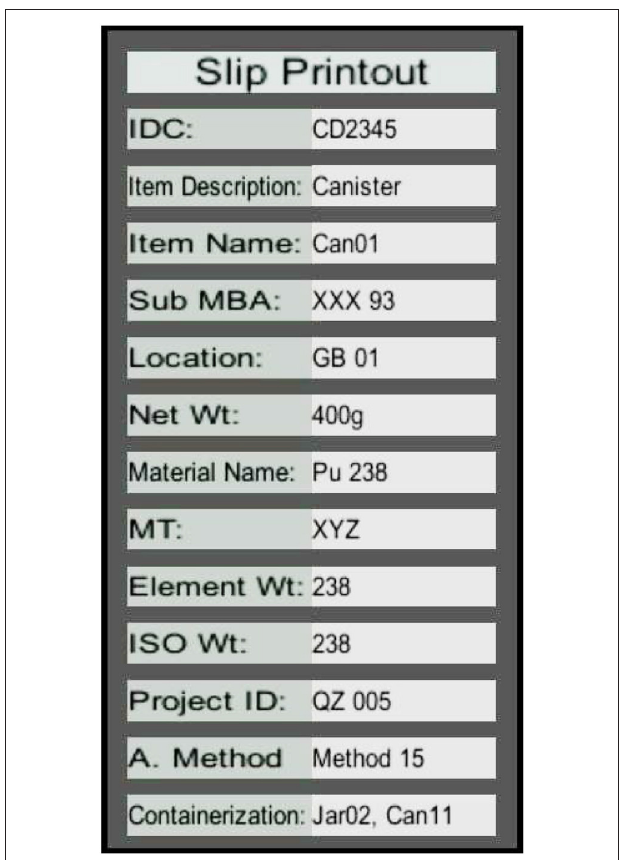
FIGURE 24 | An orthorectified view of a representative slip printout visible to the operator through the augmented reality headset.